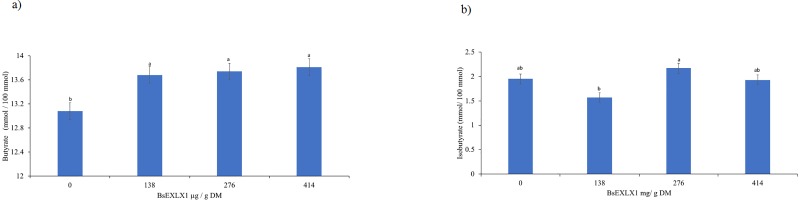
a and b. Effect of a recombinant expansin-like protein BsEXLX1 and EFE on a) butyrate, polynomial contrast showed a linear effect of dosing (P < 0.01) b) isobutyrate concentrations resulting from fermentation of a dairy cow diet, polynomial contrast showed a quadratic effect of dosing (P < 0.05). Different letters on bars indicate differences (P < 0.05). (Experiment 5).